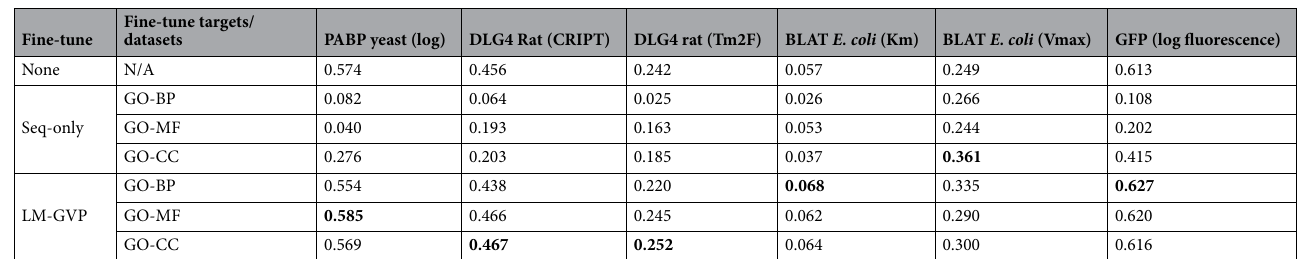
Table 4. Zero-shot performance of protein LMs in predicting mutational effects. Spearman’s correlation coefficients are shown in the table across datasets and protein LMs underwent different fine-tuning methods and tasks. The top performing model is shown in